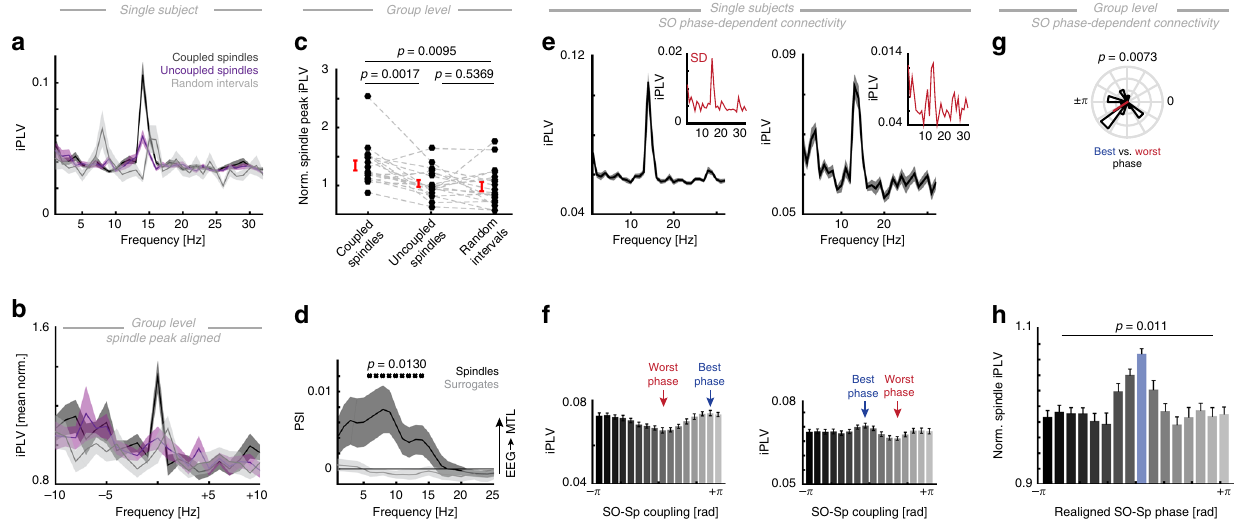
Fig. 6 Precise SO-spindle coupling phase modulates MTL-PFC connectivity. a Single subject example of EEG-MTL connectivity calculated separately for coupled spindles (black), uncoupled/isolated spindles (purple), and random event-free intervals (gray). Event numbers were equated by a bootstrapping procedure. Note the distinct peak in the spindle band. b We re-aligned power spectra to the individual spindle peak (14.5 ± 2.6 Hz; mean ± SD) and mean- normalized the aligned spectra to minimize inter-subject variability. c We then extracted the normalized EEG-MTL iPLV peak values for all events. A repeated measures ANOVA revealed a signi fi cant main effect ( F 1.49,25.27 = 7.93, p = 0.0043, η 2 = 0.21; p -values from post-hoc pair-wise comparisons are depicted). We found signi fi cantly more inter-areal connectivity for coupled than for uncoupled spindles or random event-free intervals. d Directionality analysis during spindle events revealed a signi fi cant in fl uence from prefrontal EEG spindles to the MTL (dark gray) as compared to a surrogate distribution (light gray). e Two single subject examples of event-locked spindle connectivity as a function of the precise coupling phase (mean ± SEM). Upper: the spindle band exhibits a strong peak in the spectrum and also peaks in the standard deviation spectrum (inset in red), thus, indicating that the spindle band exhibits the largest variance. f Spindle-band connectivity binned as a function of the precise coupling phase revealed strong non-uniform distributions. We highlighted the worst (lowest synchrony; red) and best (highest synchrony; blue) phase. g Anti-phasic relationship between best and worst connectivity phase (EEG-MTL: V-test against ± π : v = 7.33, p = 0.0073, mvl = 0.49). h Realigned (to the best phase) grand average spindle (12 – 16 Hz) iPLV histogram reveals a non-uniform relationship (mean ± SEM) between SO-Spindle coupling and EEG-MTL phase locking. Note we excluded the central aligned phase bin from subsequent testing (RM-ANOVA: F 5.23,88.83 = 3.13, p = 0.011, η 2 = 0.15). All error bars indicate the mean ± cortical spindle oscillation (Fig. 4f; V-test against ±pi: v = 5.13, p = 0.0434, mvl = 0.29; see also to Fig. 2d, e). This tight temporal relationship was again not present for artifactual ripple-like events (Fig. 4g; v = 1.46, p = 0.3135, mvl = 0.08). To investigate cortical dynamics relative to the ripple on longer time-scales, we calculated ripple-locked EEG time-frequency representations (±15 s) and observed a striking pattern in the spindle band, where spindle rhythmically re-occurred every 3 – 6 s (Fig. 4h). In order to quantify this effect, we calculated the spectral content of the state-dependent spindle amplitude by means of an FFT and used wakening as a control condition (absence of spindle activity). In a cluster-based permutation test, we found signi fi cantly enhanced power in the <0.5 Hz range (cluster-based permutation test: p = 0.0490, d = 0.49). We also estimated the 1/f contribution by means of irregular resampling (Fig. 4i, right panel), which further corroborated our fi nding that spindle amplitudes exhibit a slow, rhythmic comodulation over time (peak frequency: 0.37 ± 0.03; median ± SEM). Taken together, we identi fi ed oscillatory ripples events in the MTL, which exhibit a tight temporal relationship to cortical SOs and spindles on multiple timescales. Brain state dependent connectivity and directionality . We